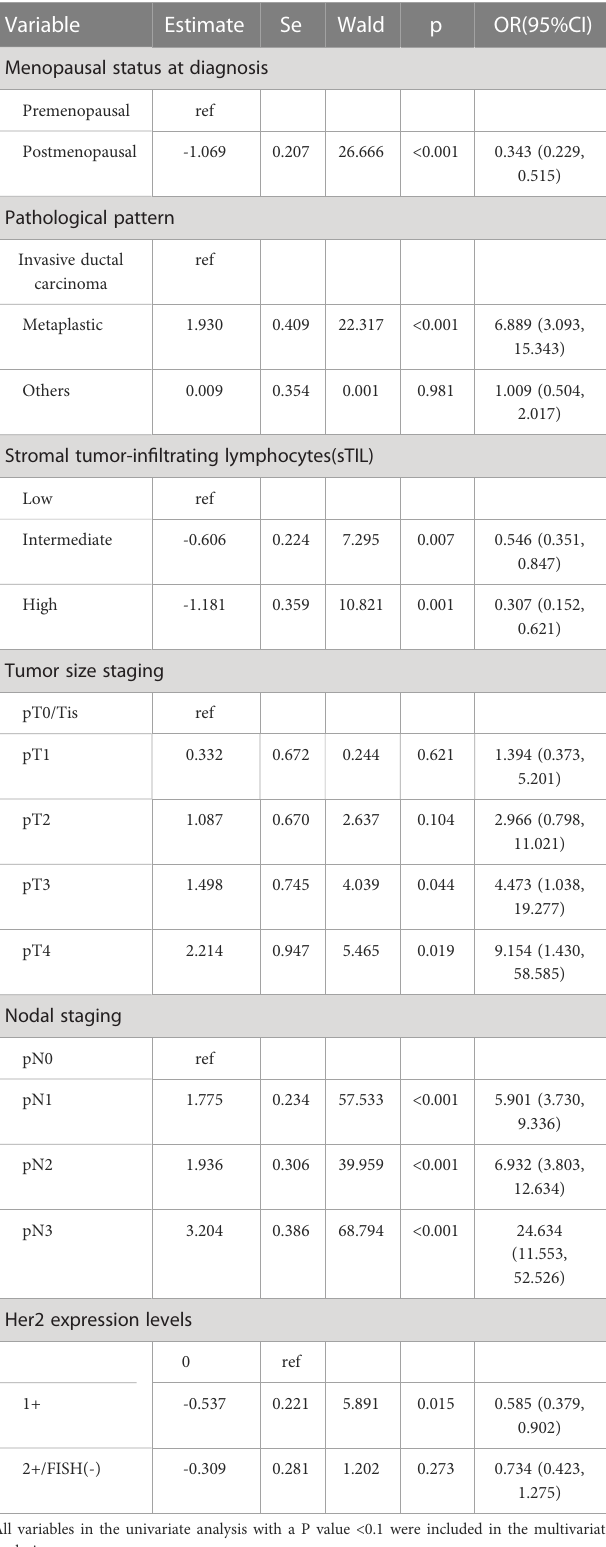
TABLE 4 Multivariate Analysis for risk factors of rapid relapse in the training